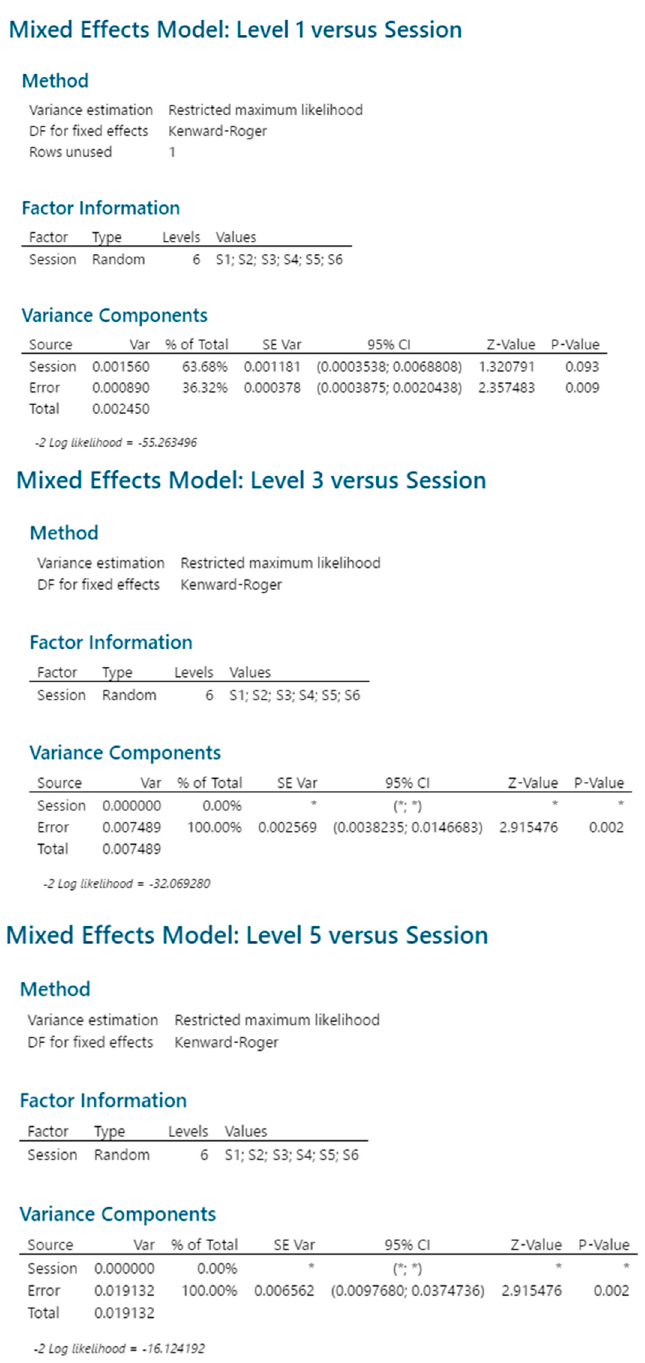
Figure A4. Variance component analysis at three different S. flexneri 6 OAg concentration levels for reproducibility in Dische colorimetric method; * not applicable.